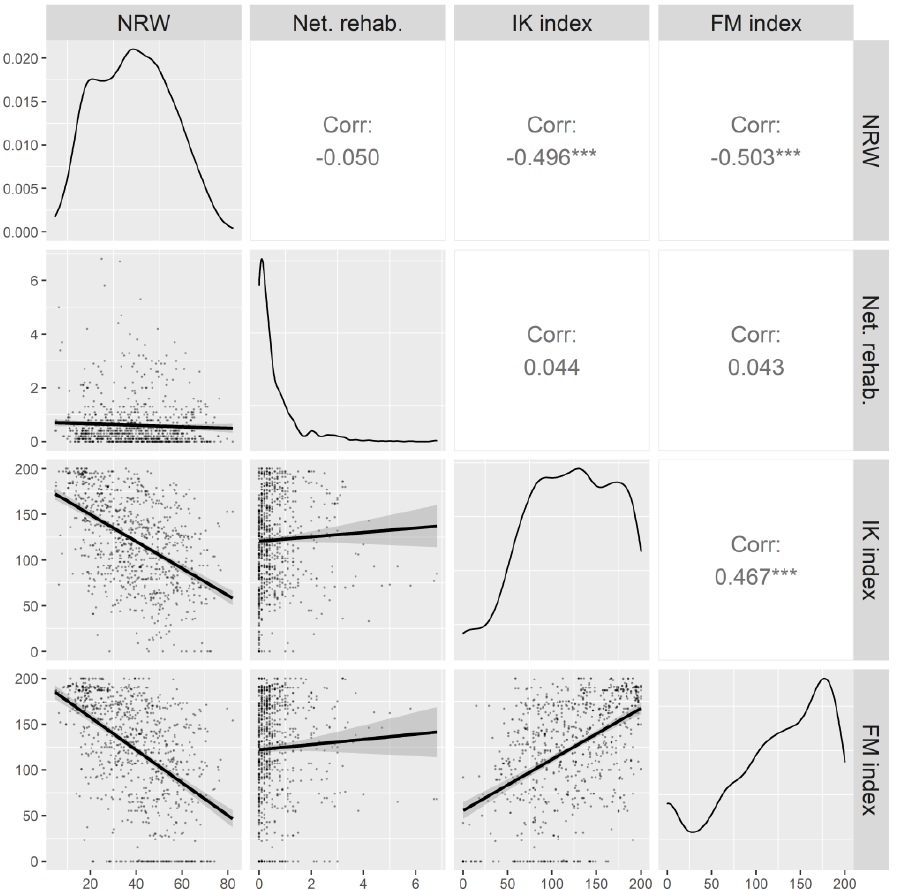
Figure 3. Correlation matrix for non-revenue water (NRW), network rehabilitation (Net. rehab.), infrastructure knowledge index (IK index) and flow-measuring index (FM index). The upper panel depicts the correlation between the continuous variables. The lower panels depict the scatter plots of the variables. The diagonal panels depict the density plots, similar to a histogram, of the variables. The stars (*) indicate the p - value of the correlation values, i.e., “***” if the p -value is <0.001, “ ** ” if the p -value is <0.01, “ * ” if the p -value is <0.05, “ . ” if the p -value is <0.10, and “ ” otherwise.